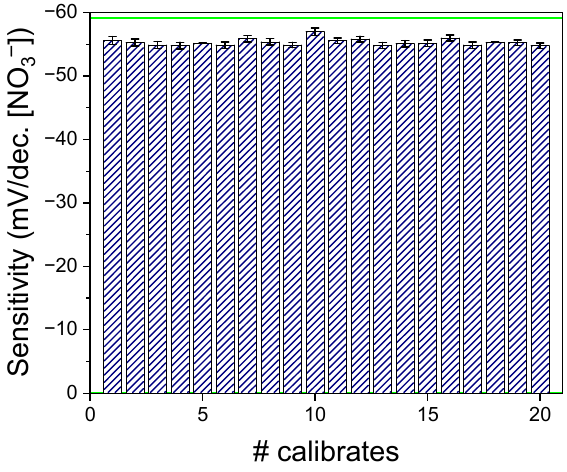
Figure 4. Stability study of the sensor. Sensitivity of 20 consecutive calibrations (380 measurements) measured in a single day. The green line represents the Nernstian theoretical value ( − 59.2 mV/dec to NO 3 − at 25 °C).